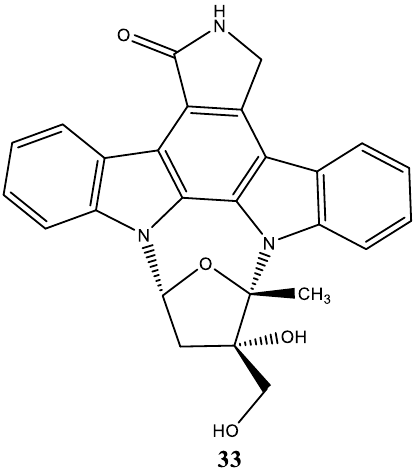
Figure 15. Structure of lestaurtinib (CEP-70, 33 ).